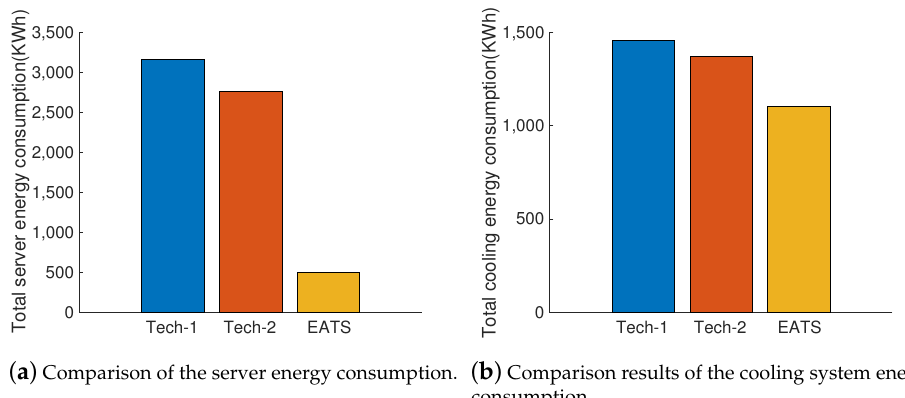
( b ) Comparison of cooling energy consumption. Figure 4. Comparison of cooling and server energy consumption for Alibaba cluster data.